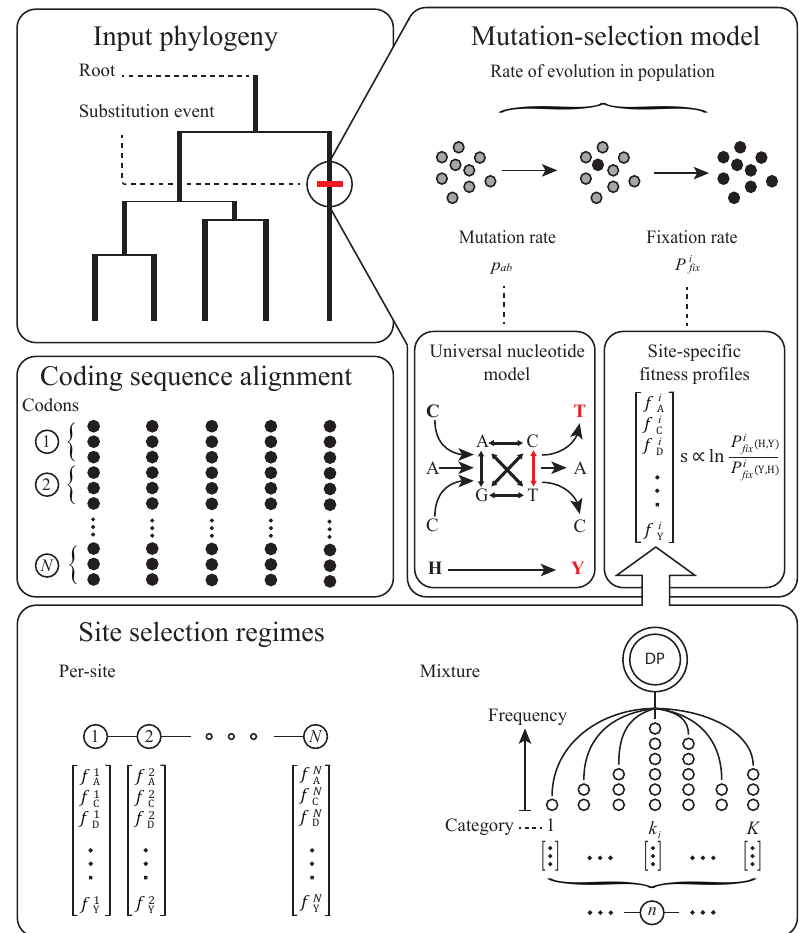
Figure 2. Schematic showing the construction of mutation-selection models in an equilibrium framework. Clockwise from top left: the model describes the DNA substitution process within a protein-coding sequence along a rooted phylogenetic tree. Each substitution is modeled by the product of a mutation rate and the rate of fixation within a population. The rate of mutation among codons is represented by the product of transition rates at each codon position. The fixation rate is represented by a population genetic model operating on a selection coefficient derived from a set of site-specific amino acid fitness values (AA values shown as single-letter codes). Fitness values may be treated as distinct parameters for each codon site, or probabilities may be calculated via a mixture over an assumed or unknown number of site categories (random effects). In a Bayesian framework the prior distribution of an unknown set of site categories may be given by a Dirichlet Process